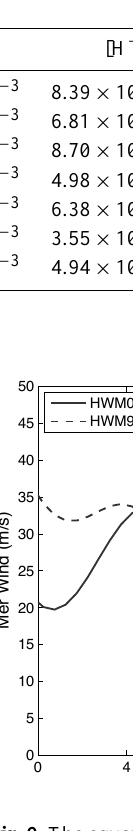
Fig. 9. The equatorial neutral winds at 300 km and 240 ◦ E predicted by HWM-07 (solid) and HWM-93 (dashed).